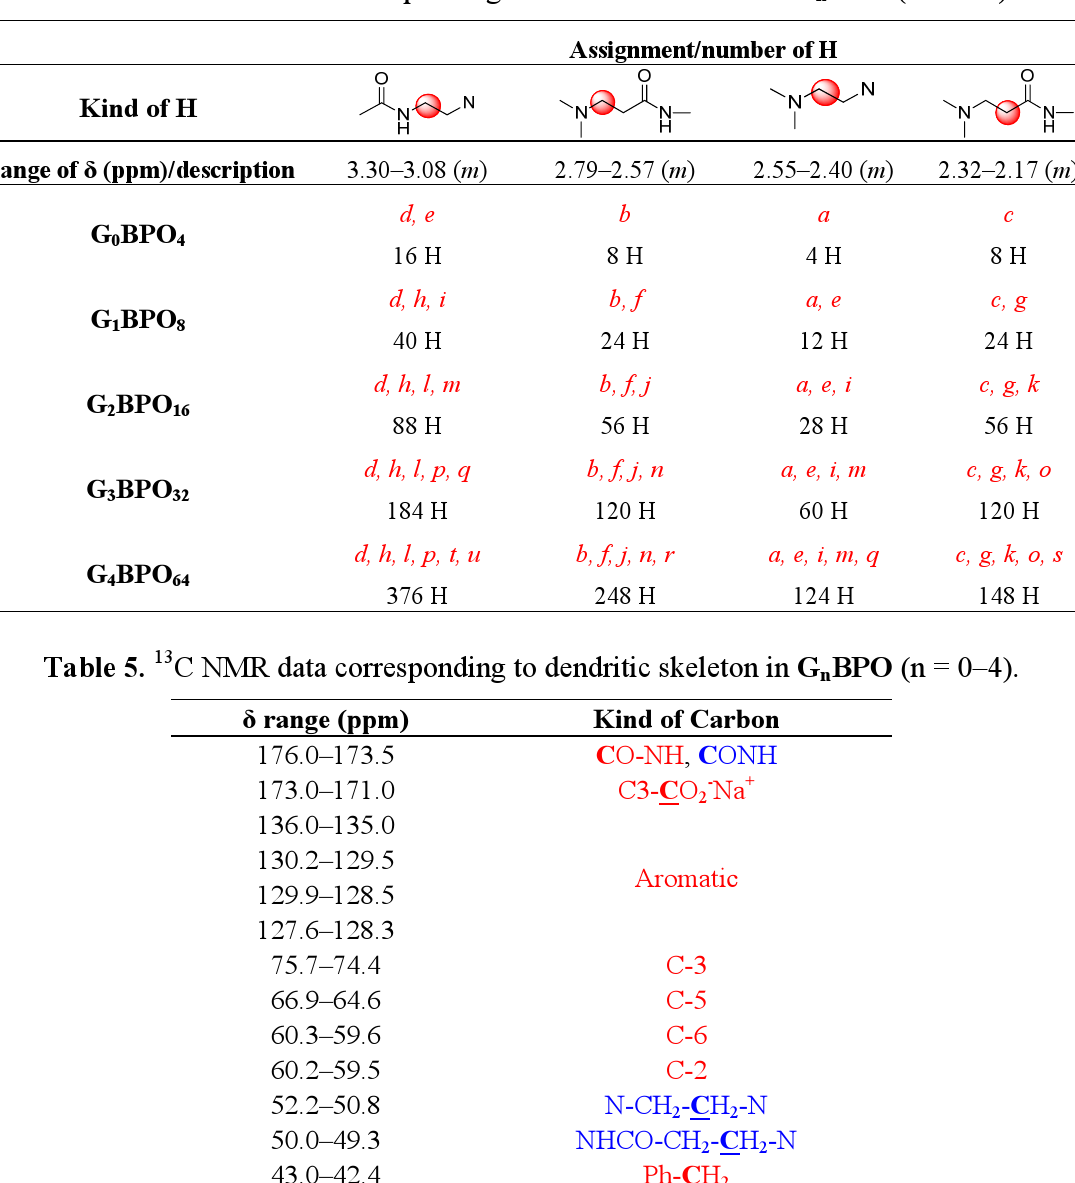
Table 3. 1 H NMR data corresponding to benzylpenicilloyl residues in G Kind of H